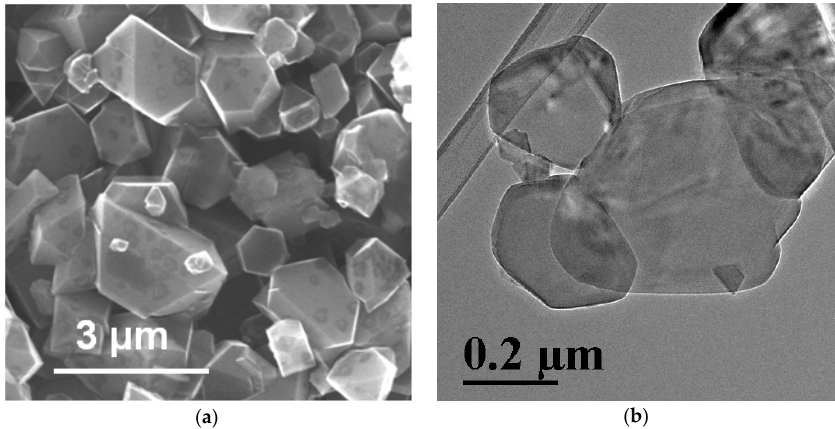
Figure 2. Raman spectra: 1—Sample N1; 2—Sample N2; 3—ordinary microdiamond.